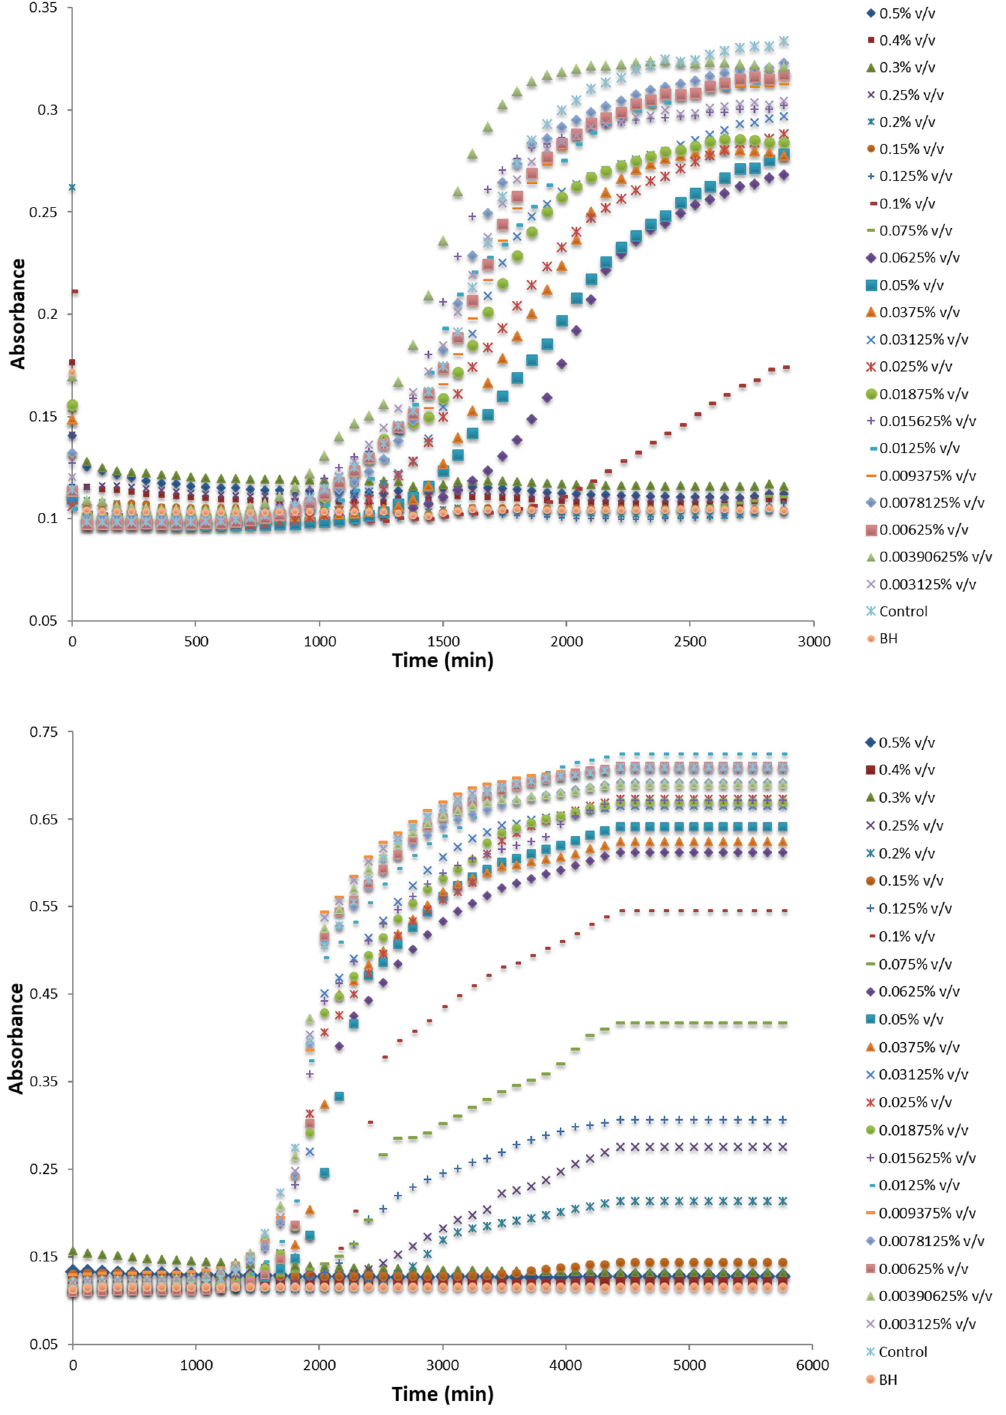
Figure 1. Typical growth curves of Paenibacillus sp. R2P2 ( upper diagram ) and Penicillium sp. R1R6 ( bottom diagram ) as observed by absorbance measurements at increasing concentrations from 0.003125% to 0.5% ( v / v ) of Satureja thymbra ( C ) essential oil in BHI and YES broth, respectively.